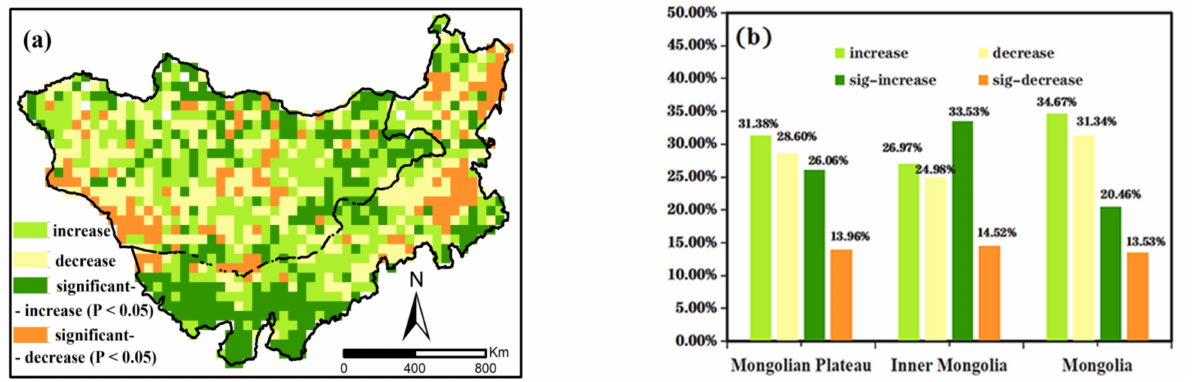
Figure 7. Spatial trends in the normalized difference vegetation index (NDVI) on the Mongolian Plateau: ( a ) Spatial distribution of NDVI, ( b ) NDVI among the different regions expressed as a per- centage of total